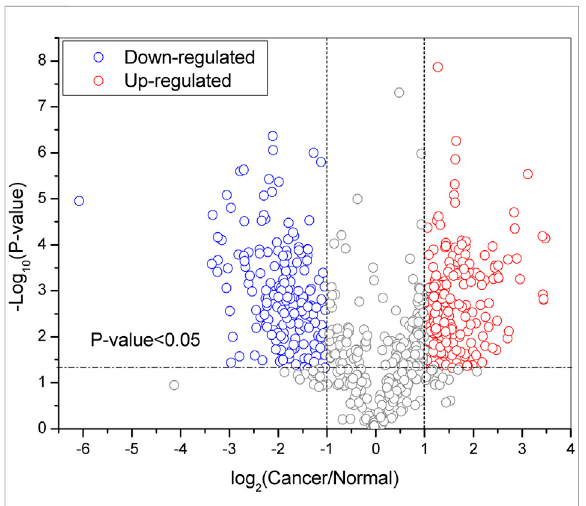
FIGURE 2 Volcano plot of DEPGs (at least two technical duplications three times) in SKOV3 vs. IOSE80 cells. Red: upregulation. Blue: downregulation. p <